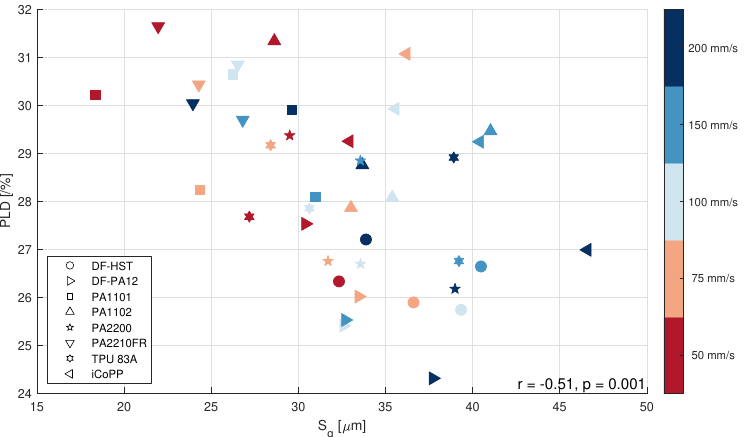
Figure 7. Powder layer density ( PLD ) vs. powder surface roughness ( S q ) for all materials and speeds. The material exhibiting the highest correlation between PLD and S q is again DF-PA12 ( r = − 0.88, p = 0.04). Finally, a comparison between PA1102 and TPU 83A can be observed in Figure 8: these two materials represent two very different PSDs ( D 50 = 50 µ m and D 50 = 80 µ m, respectively) and it seems that their behavior is different, with a sharper decrease of the PLD value with increasing S q for PA1102 compared to TPU. So, it seems that the PSD influences somehow both S q and PLD , but more experiments are needed to exclude the influence of other (uncontrolled) variables.